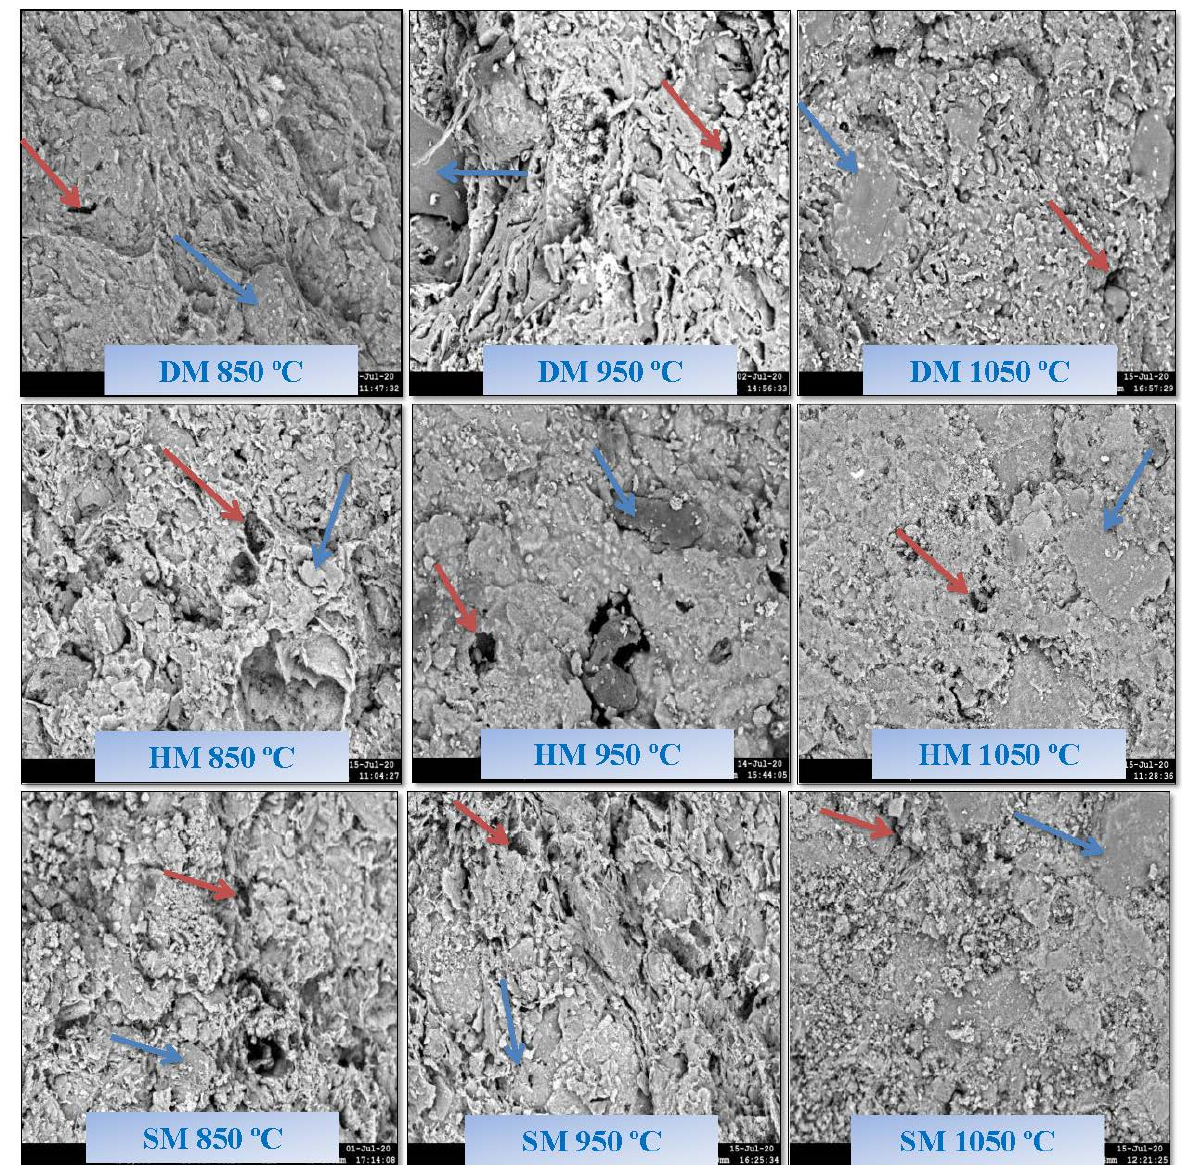
Figure 13. SEM micrographs of fired bricks of DM, HM, and SM at 850 °C, 950 °C, and 1000 °C, respectively.. Red arrows show pores and blue arrows show vitrification.